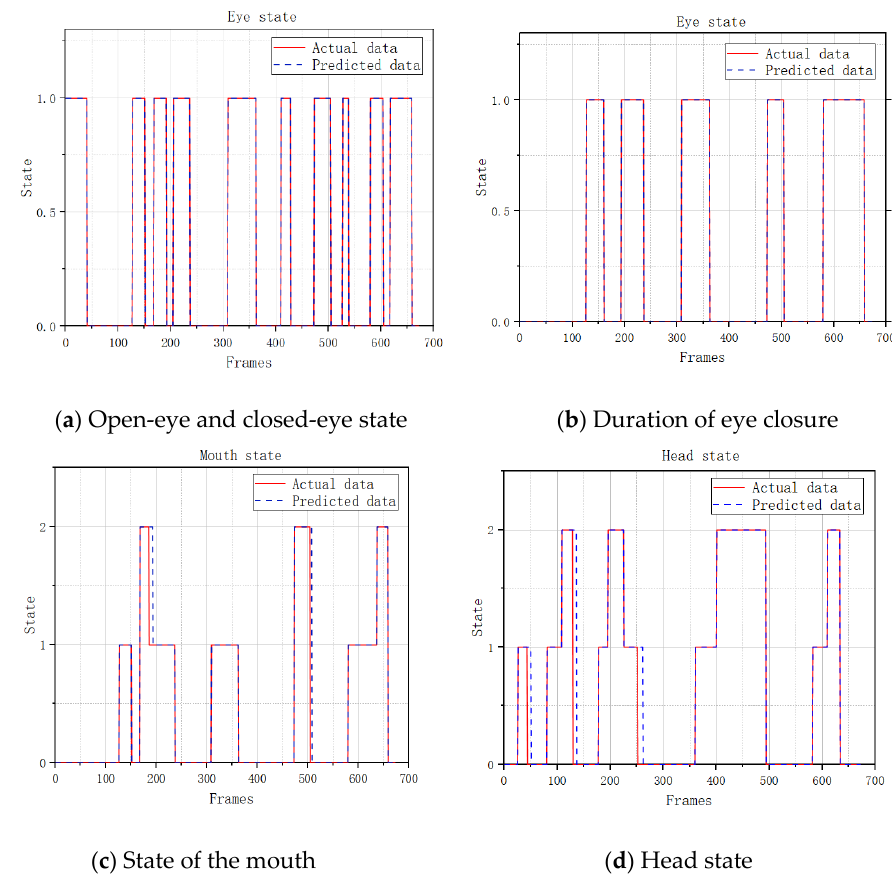
Figure 12. Fatigue indicator accuracy test.